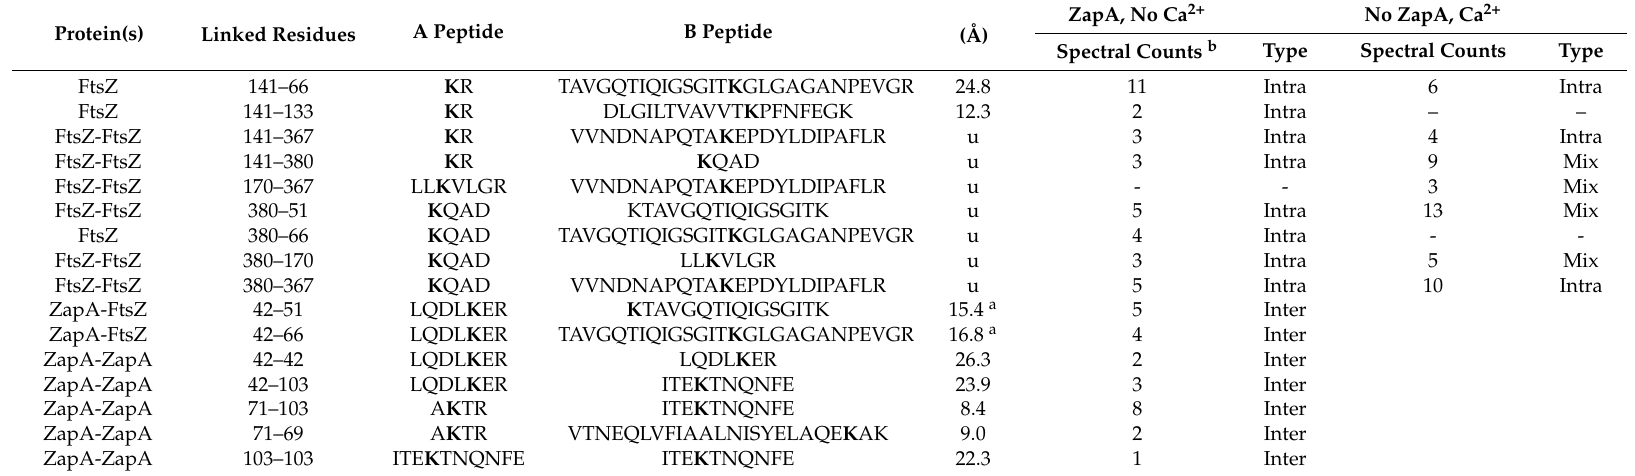
Table 1. Overview of identified cross-linked